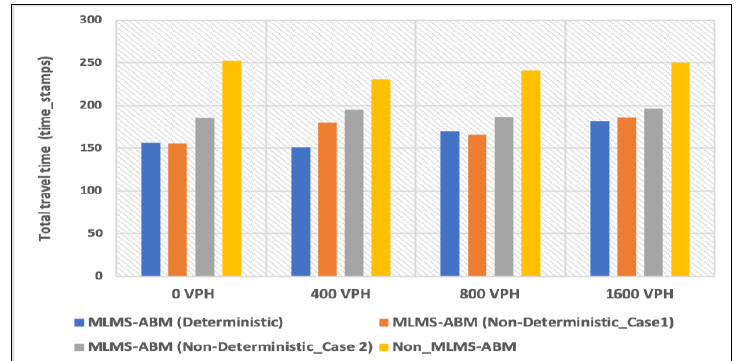
Figure 12. Total travel time through the I-25 freeway in different methods with different traffic loads.